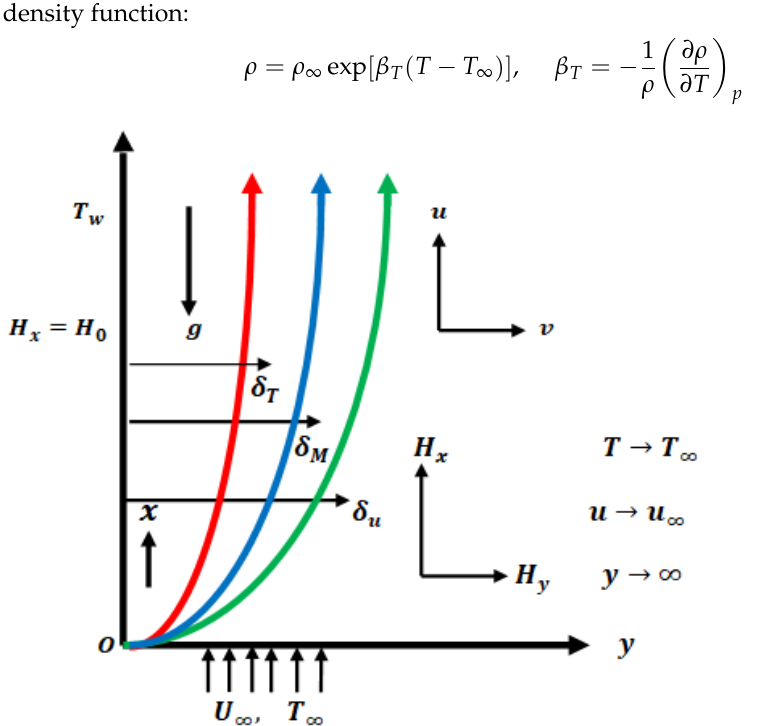
Figure 1. Coordinate system and flow geometry.